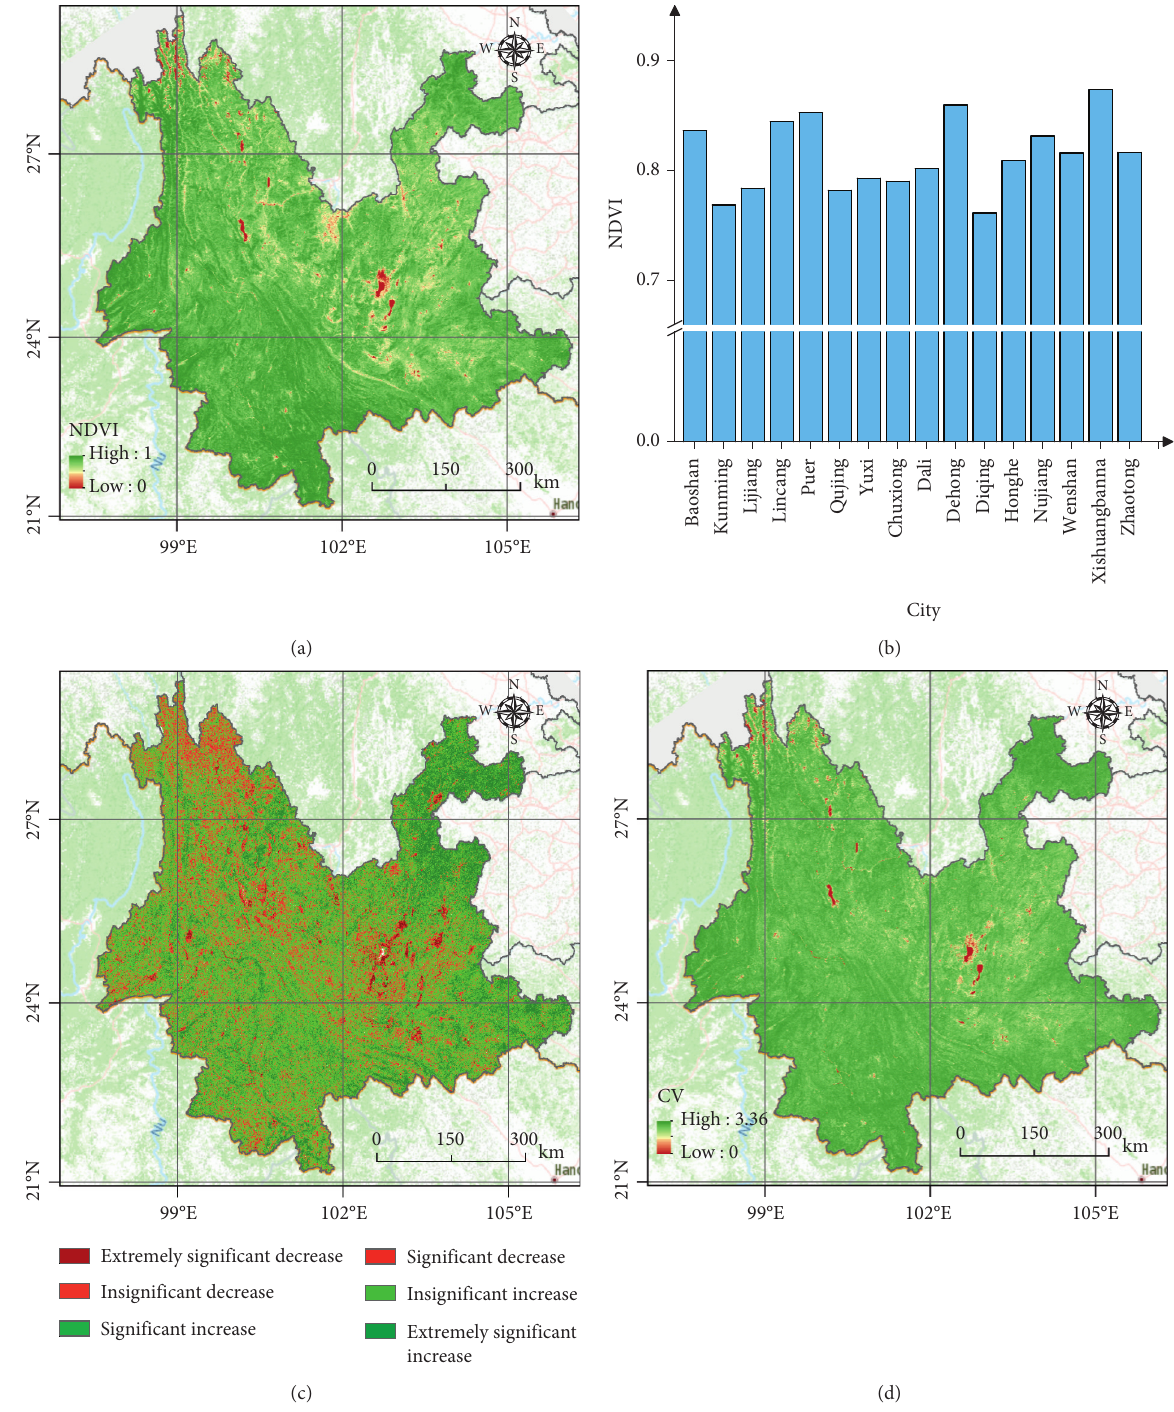
Figure 3: The characteristic spatial patterns of NDVI. (a) Spatial distribution of NDVI of Yunnan Province from 2001 to 2018; (b) characteristics of NDVI in different cities; (c) trends of the NDVI based on the M-K significance test across the Yunnan Province during 2001–2018; (d) stability of NDVI change across the Yunnan Province over